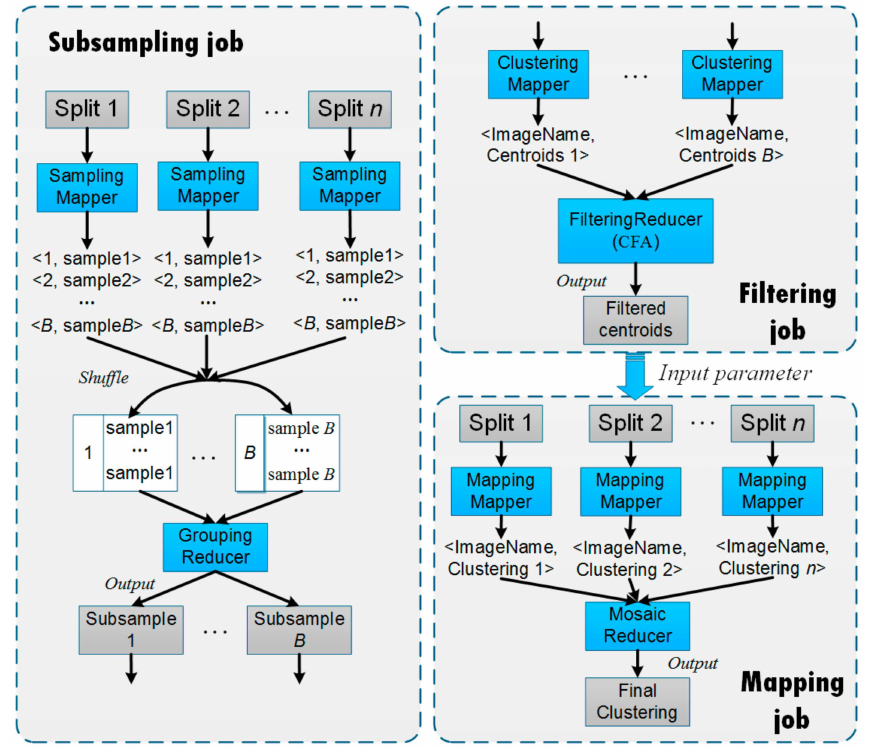
Figure 6. The MapReduce-based implementation of